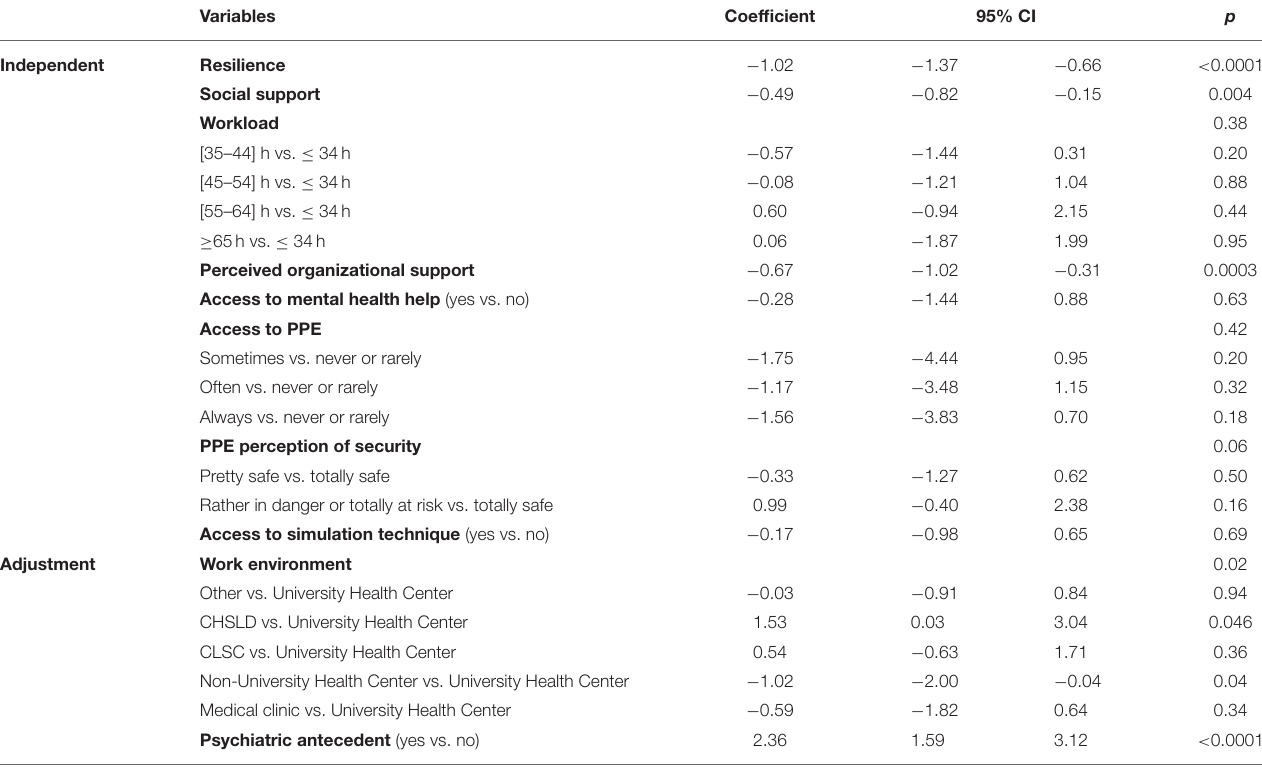
TABLE 5 | Adjusted coefficient, 95% confidence interval and p -values from multivariable linear regression analysis for anxiety scores among healthcare workers ( n = 421).